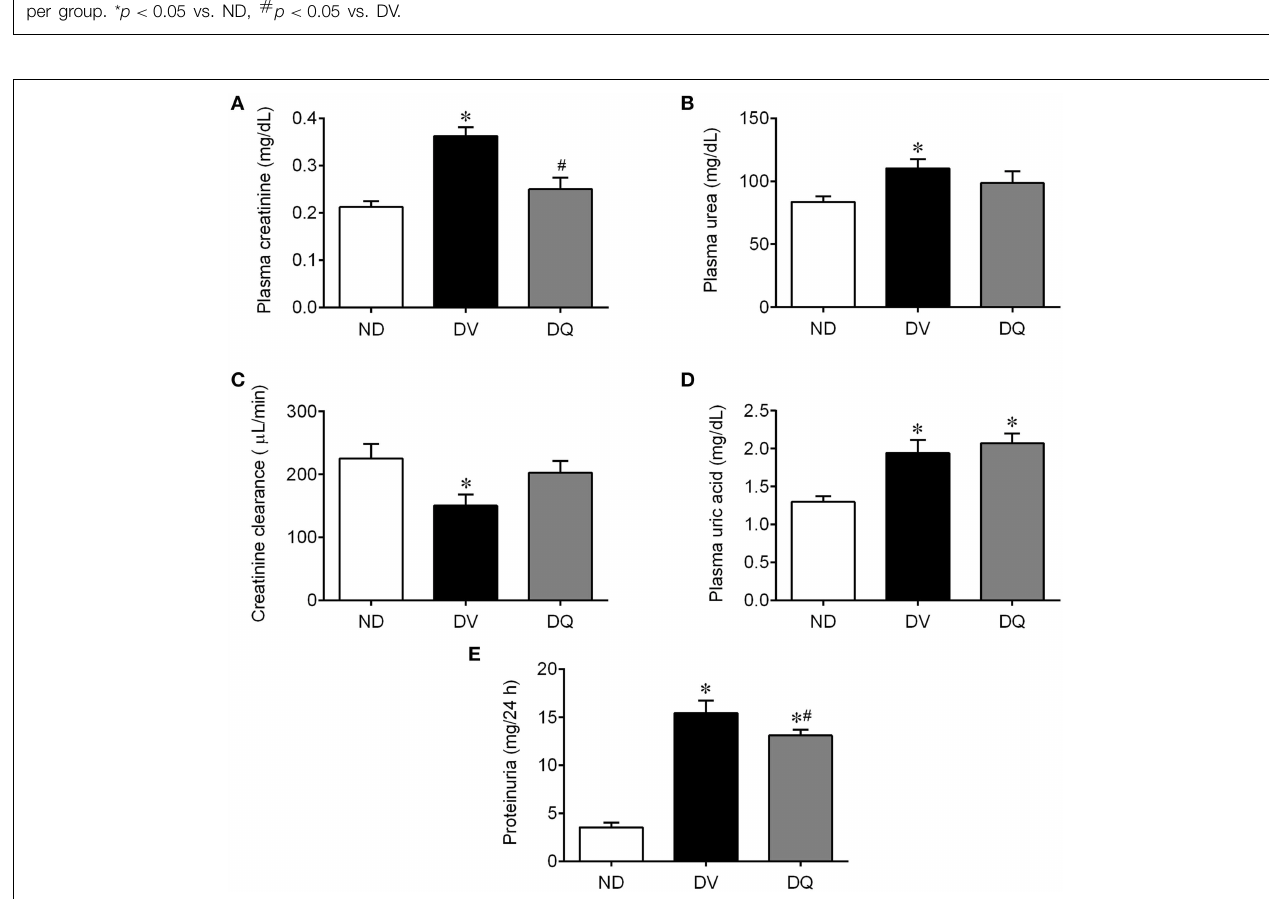
FIGURE 3 | Plasma creatinine (A), urea (B), creatinine clearance (C), uric acid (D), and proteinuria (E) in diabetic apoE − / − mice treated with quercetin (DQ) compared with diabetic apoE − / − mice administered vehicle (DV) compared with non-diabetic apoE − / − (ND) mice. Values are the means ± SEM for n = 6 –8 mice per group. * p < 0 . 05 vs. ND, # p < 0 . 05 vs. DV.